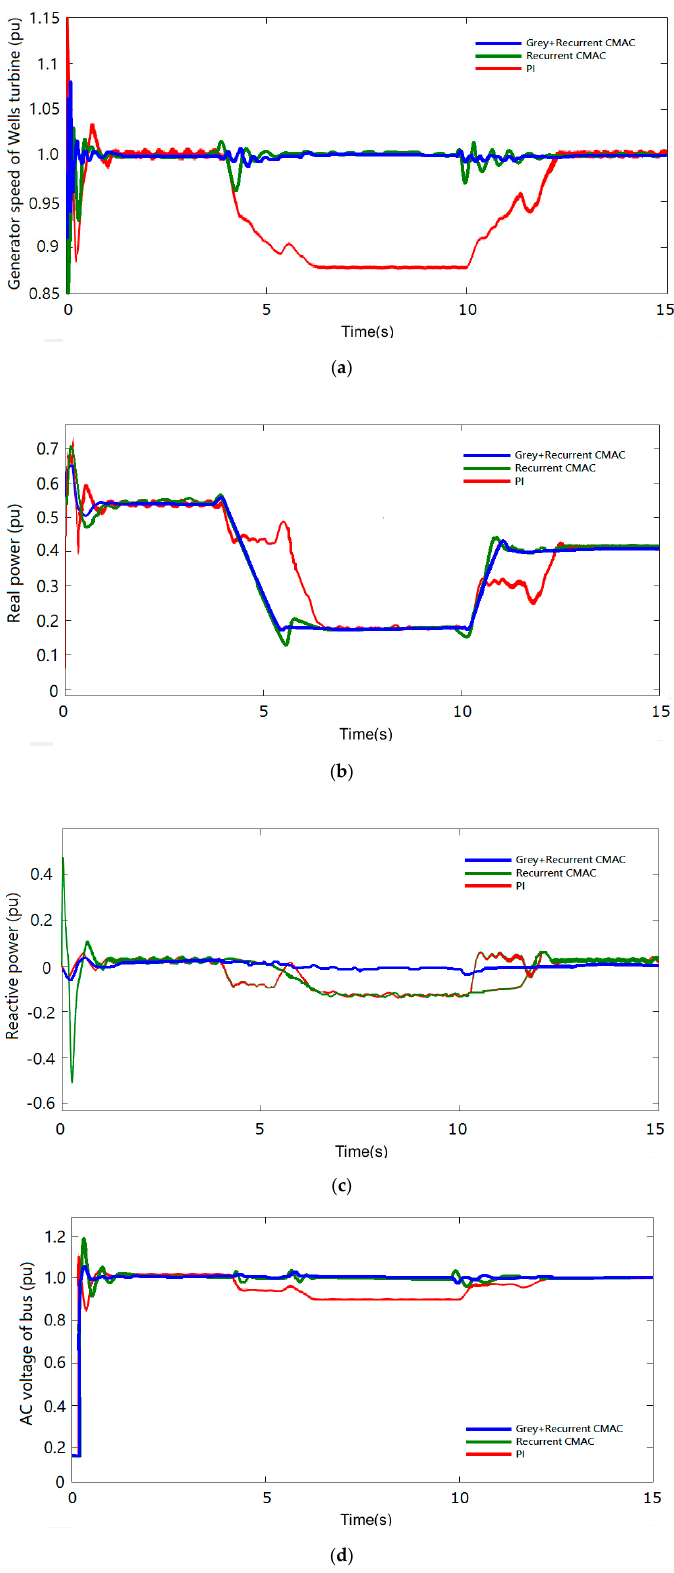
Figure 4. Dynamic responses to speed changes for the studied system: ( a ) Wells turbine’s rotor speed response, ( b ) the real power response of WECS, ( c ) the reactive power response of WECS, and ( d ) dynamic voltage amplitude response of AC bus on power grid side.